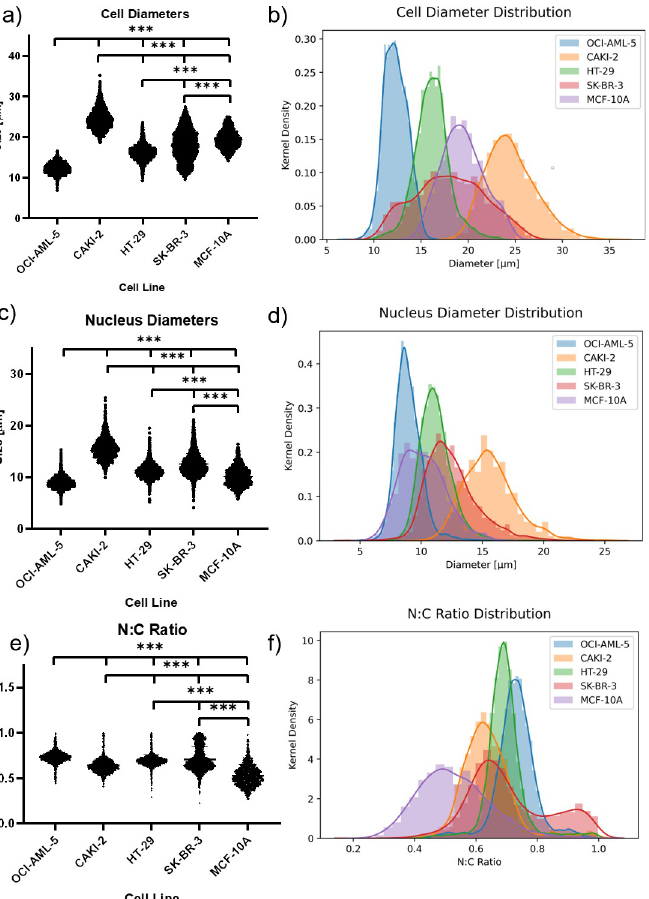
Fig 2. Cell diameter, nuclear diameter, and N:C ratio distribution. (a, c, e) Beeswarm plots and (b, d, f) density distributions display (a, b) cell, (c, d) nucleus, and (e, f) N:C ratio distribution across cell lines. Triple asterisks indicate a p -value of < 0.001.